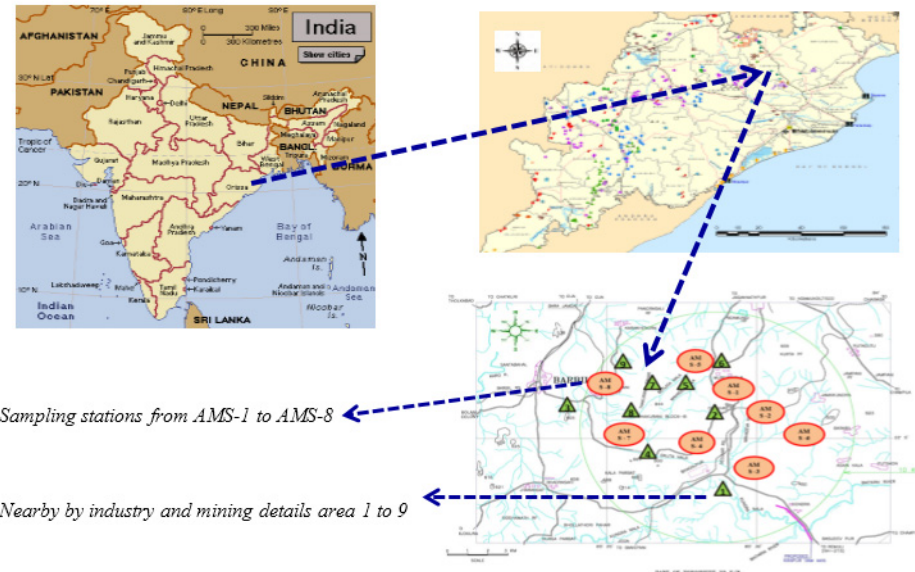
Fig. 1: The geographic location of stations in the study area